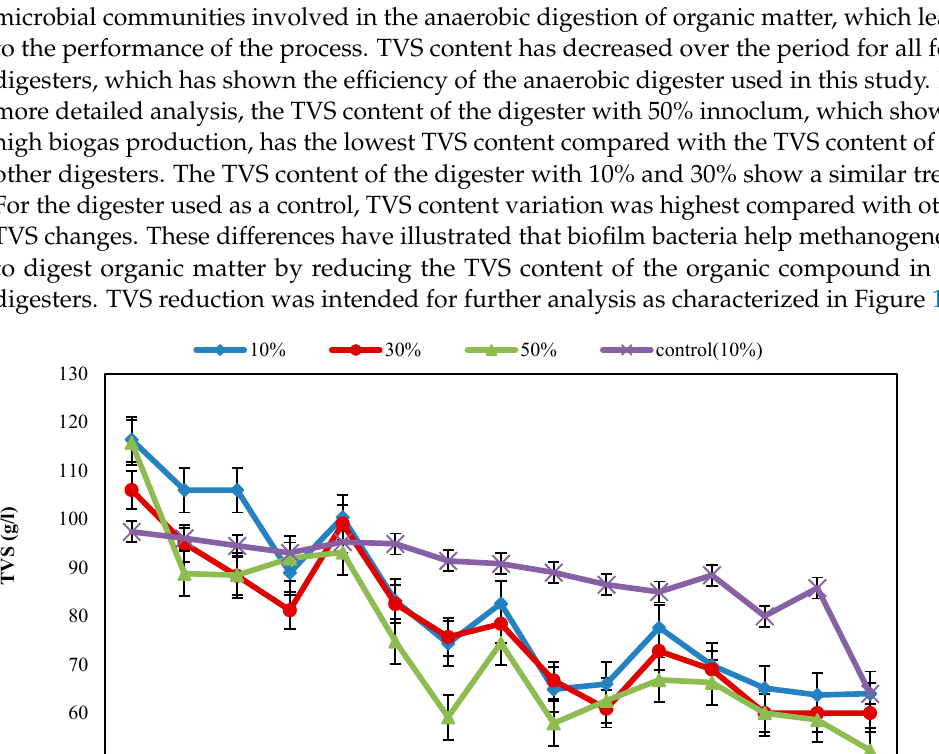
Figure 13. Percentage of TVS reduction (%) in the digesters with different inoculum-to-feed ratios with digestion time of 14 days. Volatile solids reduction measurement in anaerobic digestion is an indirect measure- ment of organic compounds utilized in the anaerobic digester. Therefore, in this study, the TVS reduction was calculated to measure organic matter transformed into biogas. From the graphic analysis, TVS has increased over the period starting from day 0 with 0% removal for each digester and ended at day 14 with TVS reduction of around 60% for the digester with 50% inoculum, 43.4% for the digesters with 30% and 10%, and only 29% for the control. Overall, TVS reduction in the digesters by 10%, 30%, and 50% increased sim- ilarly and the difference between the TVS reduction of each digester was not significant. TVS reductions in the three digesters of the hydrolyzed food waste with biofilm were higher than the TVS reduction in the digester without hydrolysis and biofilm. Obviously, biofilm is capable of reducing the high amount of TVS and producing a significant volume of biogas based on the comparison between the biogas volume produced and TVS reduc- tion represented in the figures. Thus, several studies have reported that TVS reduction for food waste anaerobic was mostly varied between 40 to 60%, as shown in this study [44,59]. For additional information, the total TCOD of the digesters at the initial and final mwere measured and TCOD reduction was calculated as represented in the following section.